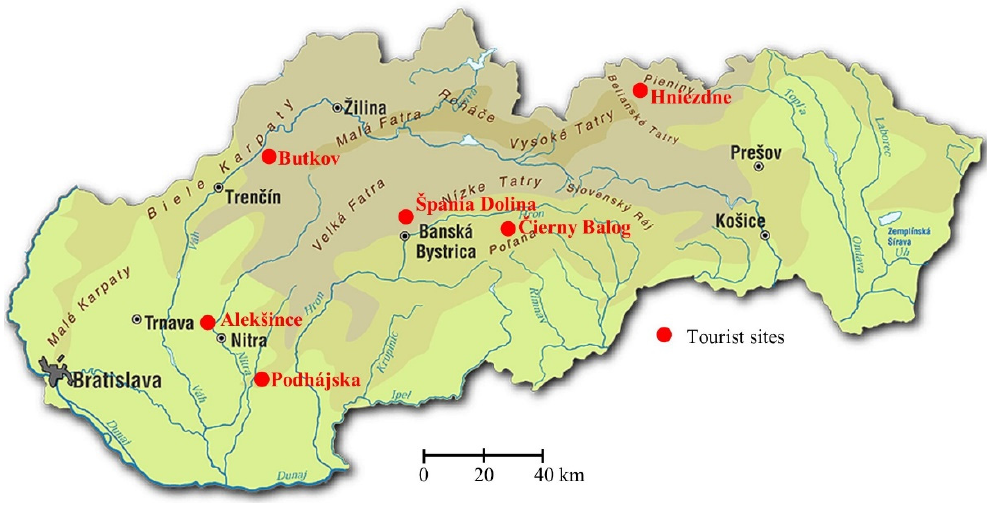
Figure 1. Selected tourist sites and their localization in Slovakia. Source: Adapted with permission from ref. [36]. Copyright 2005–2021 e-Slovensko.cz.